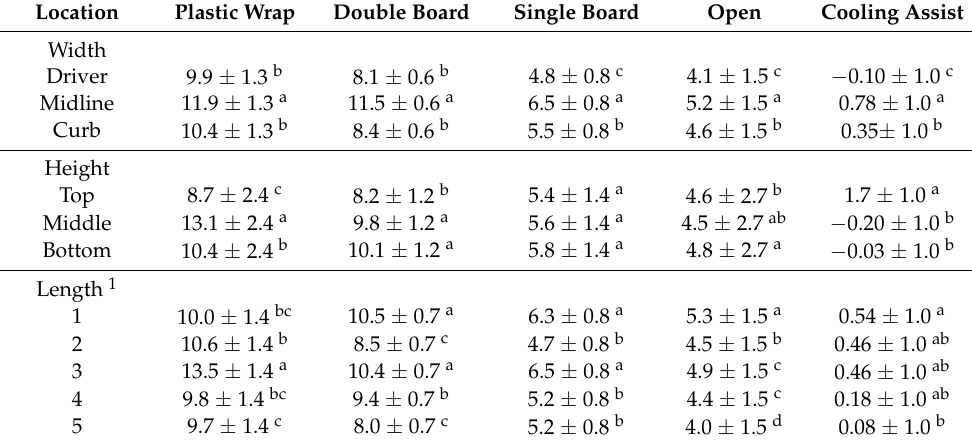
Table 5. Spatial variation of air temperatures elevation above-ambient ( ∆ t, ◦ C) across the trailer during transport in different seasons.